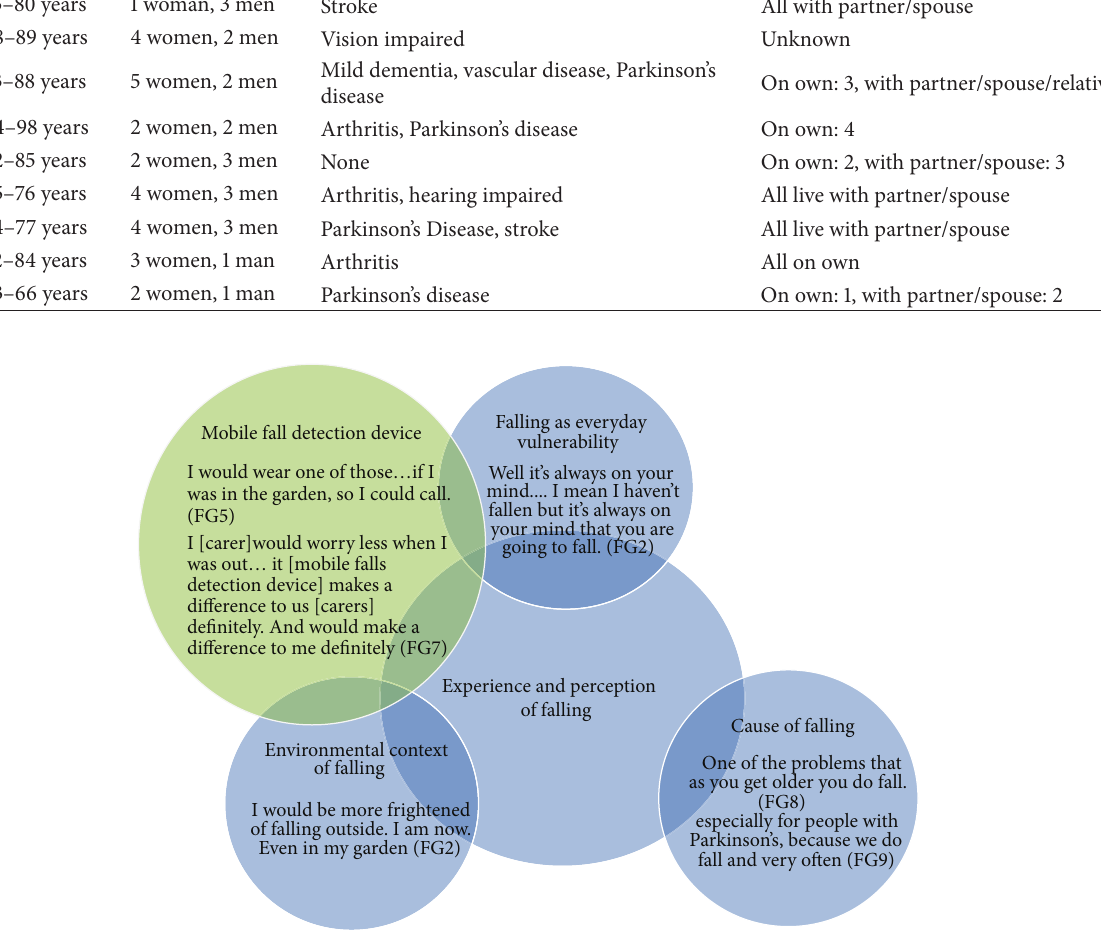
Figure 1: Experience of falling amongst older people and potential impact of mobile falls detection